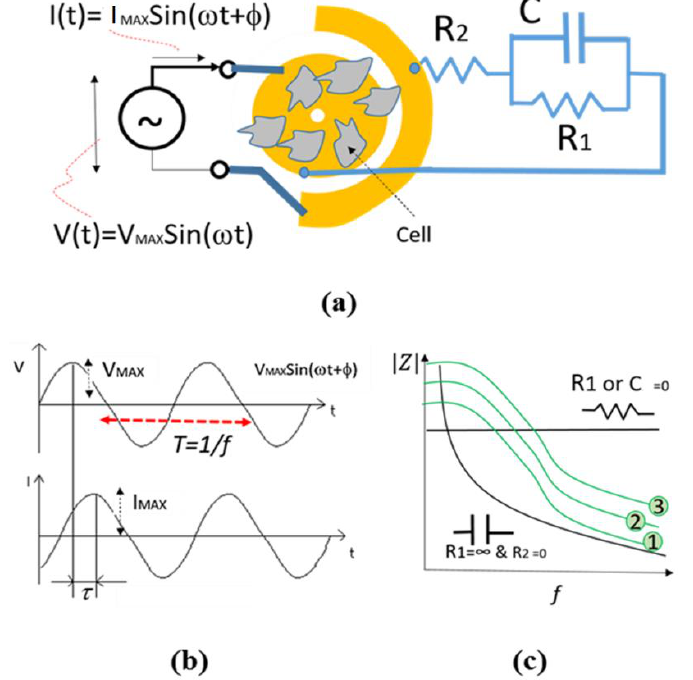
Figure 3. Principle of impedance measurement: ( a ) schematic of electrode and its equivalent circuit, ( b ) the sine wave voltage and current signals and ( c ) the impedance frequency response of electrode. The magnitude of impedance between the electrodes can be represented by Equation